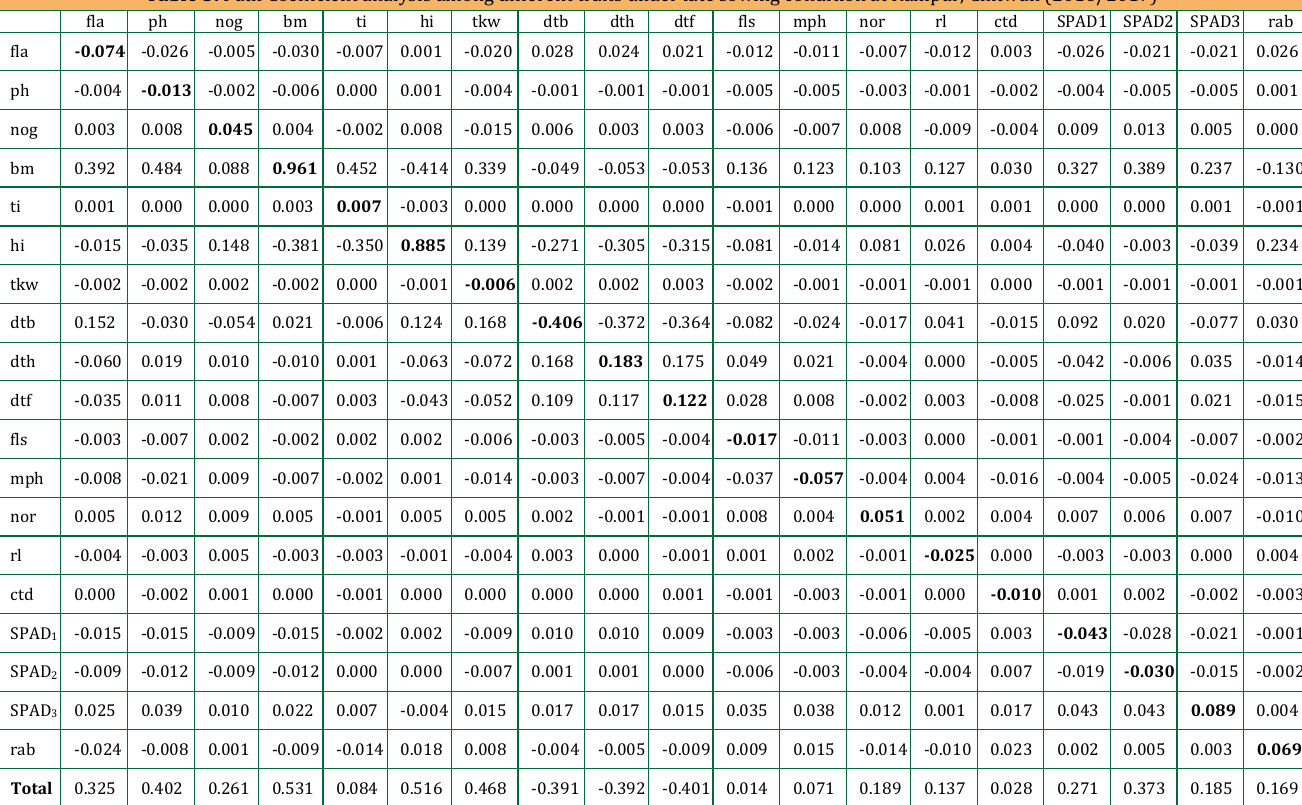
Table 3: Path Coefficient analysis among different traits under late sowing condition at Rampur, Chitwan (2016/2017) fla